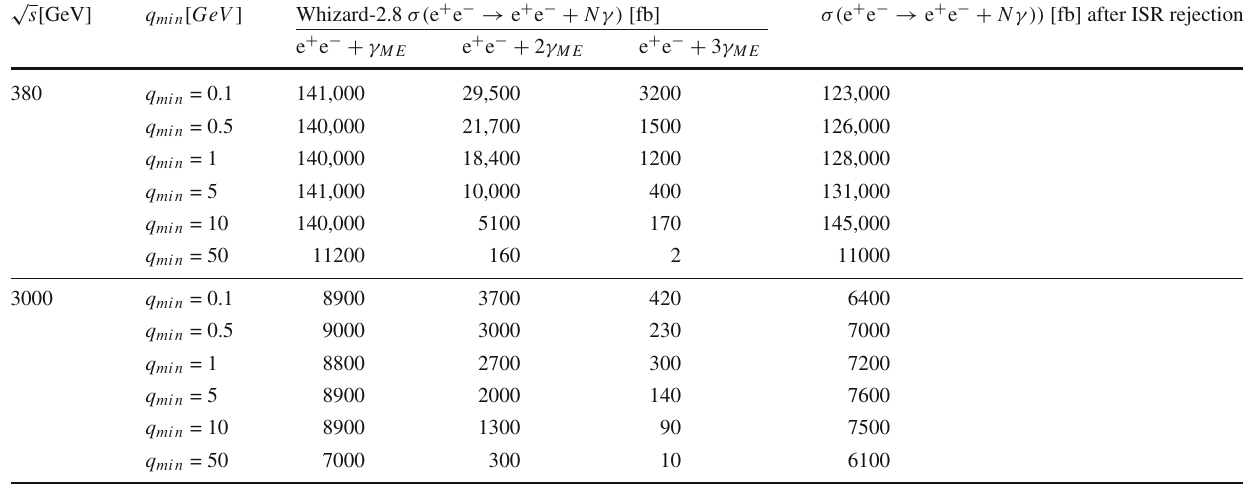
Table6 Crosssectionvaluesfordifferentmergingparameter q min anddifferentmultiplicitiesofphotonsincludedinthematrixelementcalculations in Bhabha events with a requirement of at least one of the matrix elements photons to be ’hard’. Number of significant digits indicates the statistical precision resulting from Whizard integration